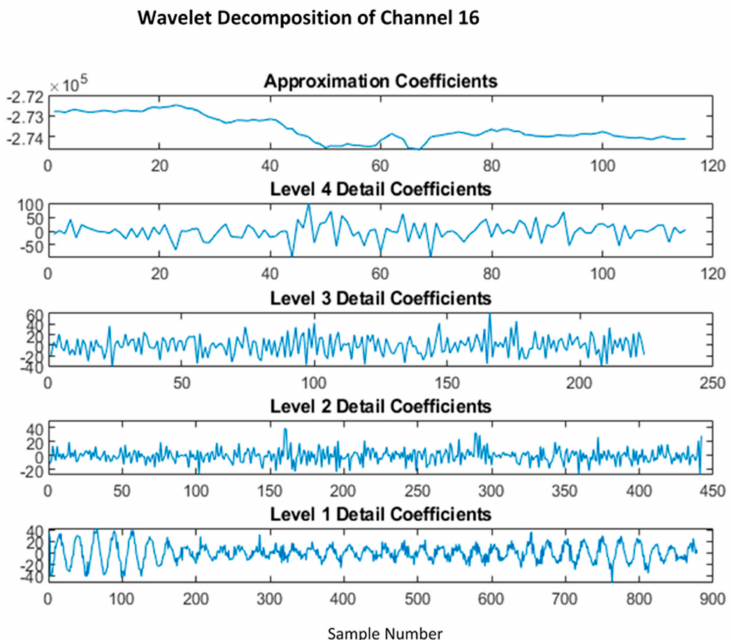
Figure 15. 4-level wavelet decomposition using sym4 wavelet.